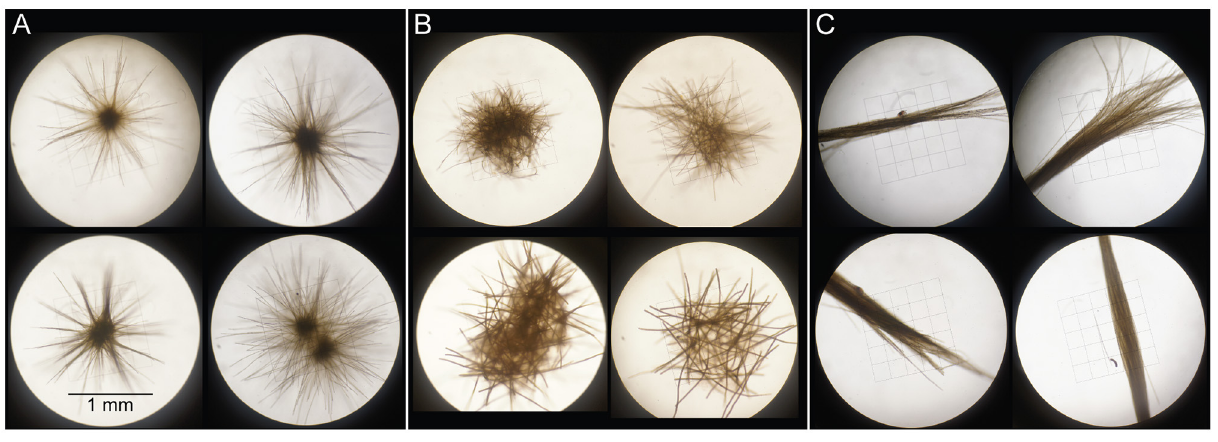
FIGURE 1 | Examples of Trichodesmium colonies sorted into the morphological classes “radial puffs” (A) , “non-radial puffs” (B) , and “tufts” (C) on 23 Mar 2014. On all other collection days, “puffs” designate mixtures of morphotypes (A,B) , “tufts” designate morphotype (C) , and “mixed” designates mixtures of all